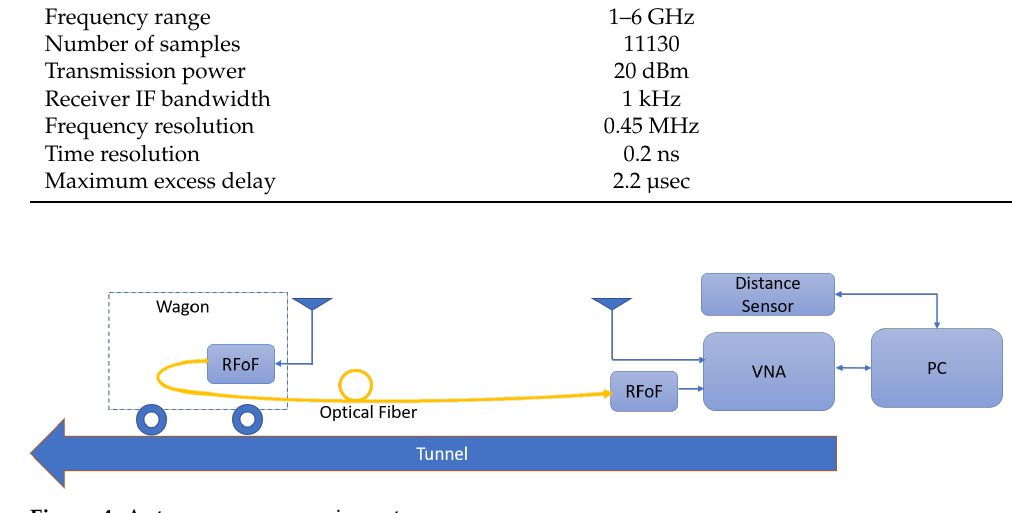
Figure 4. Autonomous measuring